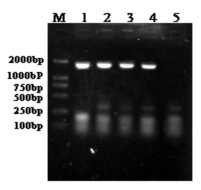
Identification of recombinant PRV SA215/VP2 by PCR amplication of VP2 gene. PCR products were analyzed by 0.8% gel agarose electrophoresis. Lanes: (M) Marker DL2000; (1-3) Samples of Vero cells infected with PRV SA215/VP2; (4) Positive control, PPV; (5) Vero cells infected with vector virus PRV SA215.